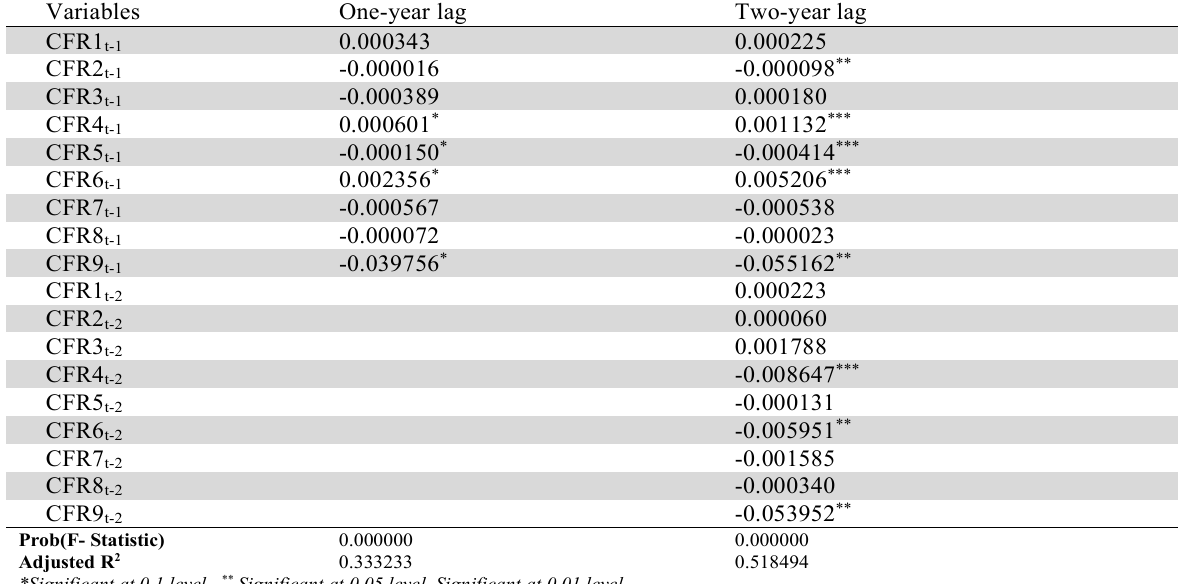
Evaluation of predictability in cash flow forecasting models